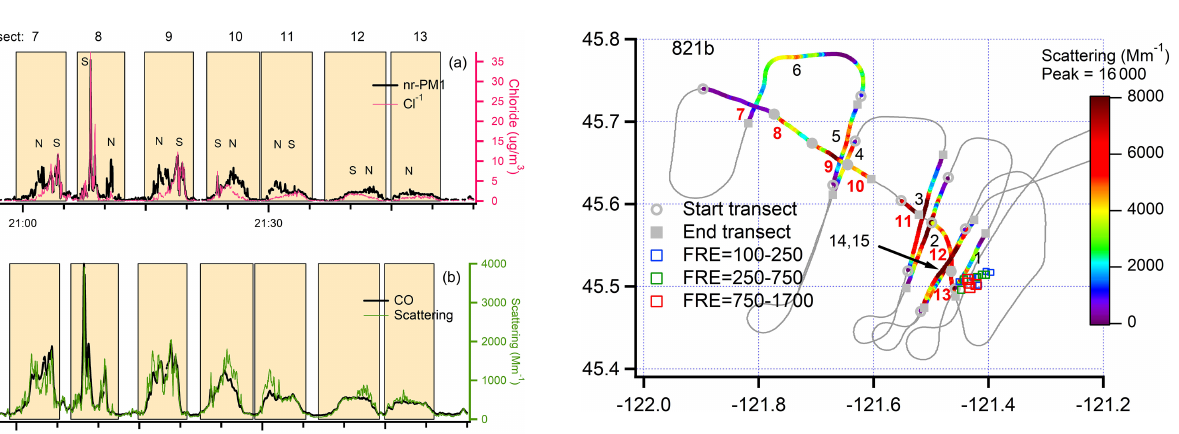
Figure 7. Ground track for flight 821b with transects colored ac- cording to light scattering. Transects are labelled 1–15 in order of increasing flight time. Fire is near transect 1. Transects 6 and 7 are furthest downwind. Along-plume transects, 7–13, labelled in red. Transect 11 had limited NO x data and is not included in graphs in which photochemical age is the independent variable. After the along-plume segment, the plume was crossed twice (in opposite di- rections) on transects 14 and 15. MODIS retrievals between 18:00 and 22:00 used for FRE. Latitude and longitude not to